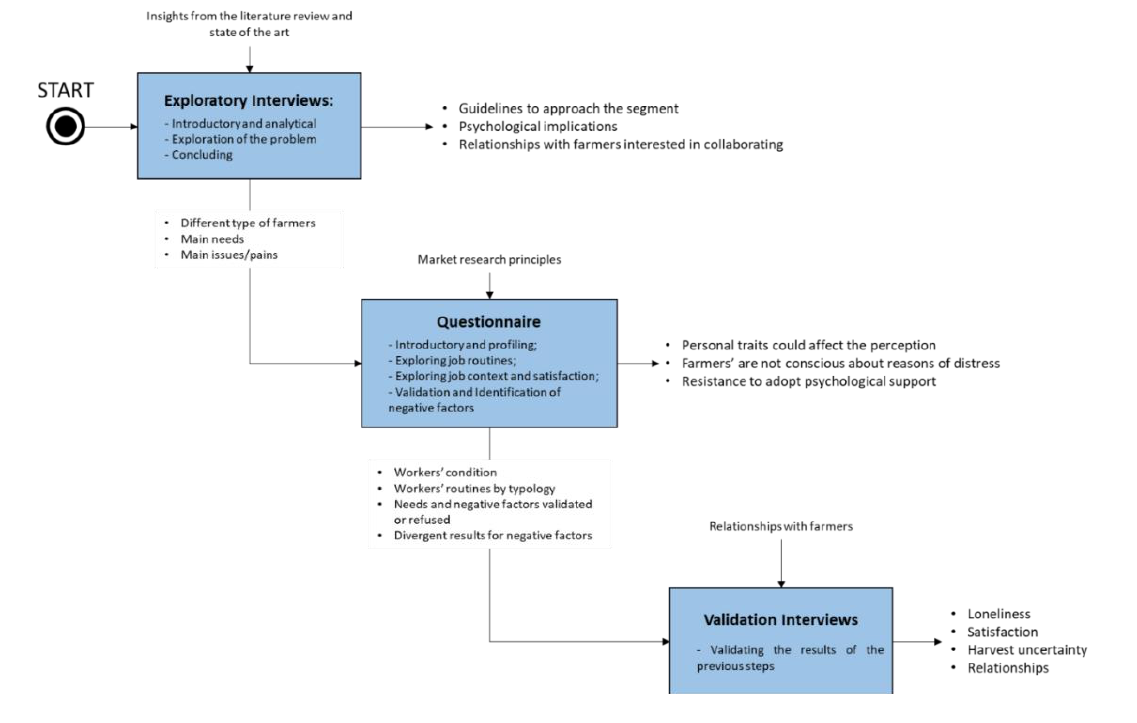
Fig. 3 : Research flow